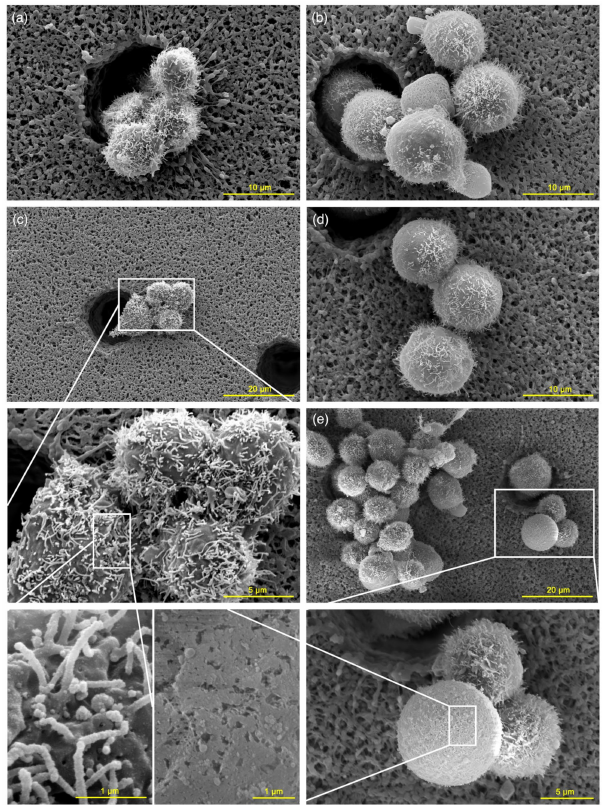
Figure 2. Cell morphology. SEM images. The cells were filtered through the polymer membrane and fixed with paraformaldehyde immediately after nsPEF exposure. ( a , c ) Sham samples. Morphology of TM3 cells in control samples with a folded cell membrane and numerous microvilli on the surface. ( b , d , e ) nsPEF-exposed cells. An increase in the diameter of cells, loss of microvilli, areas of roughness, and plasma membrane blebbing can be